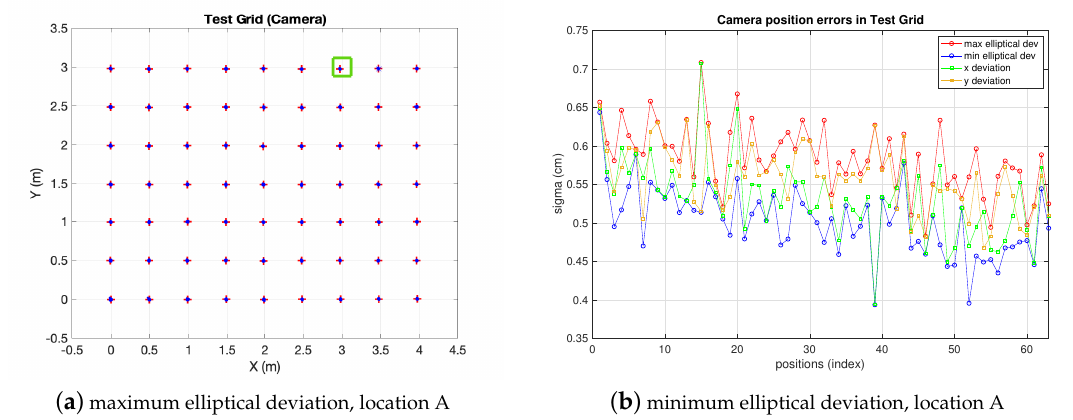
Figure 5: the deviation in x , y axis are between 0.46 cm and 0.7 cm and between 0.47 cm and 0.65 cm values respectively, being the 68% confidence ellipse within margins of 0.5 cm and 0.66 cm and between 0.4 cm and 0.65 cm (ellipse axis respectively).